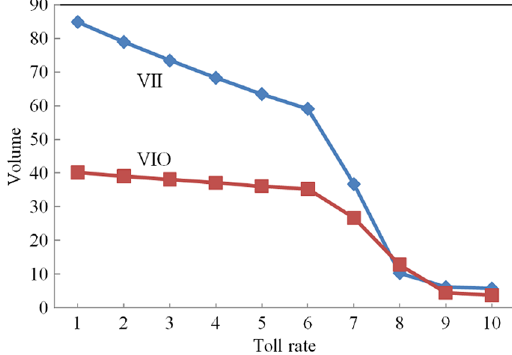
Fig. 10. Travel time under different elastic